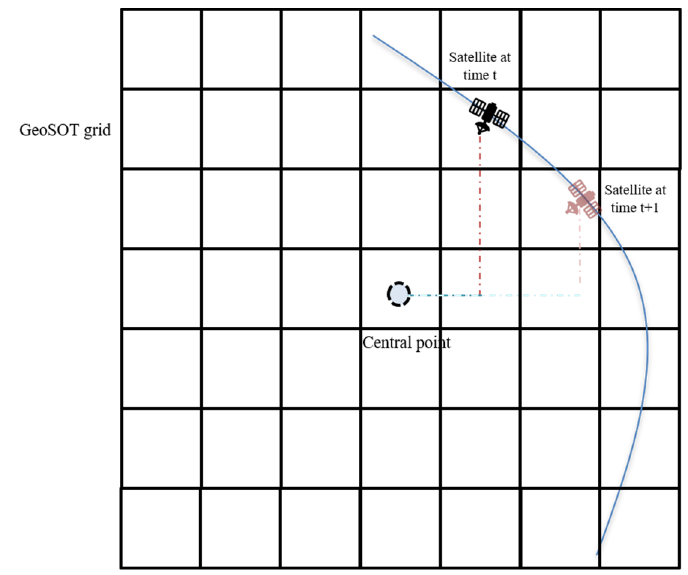
Figure 6. Schematic diagram of grid calculation of satellite motion process.